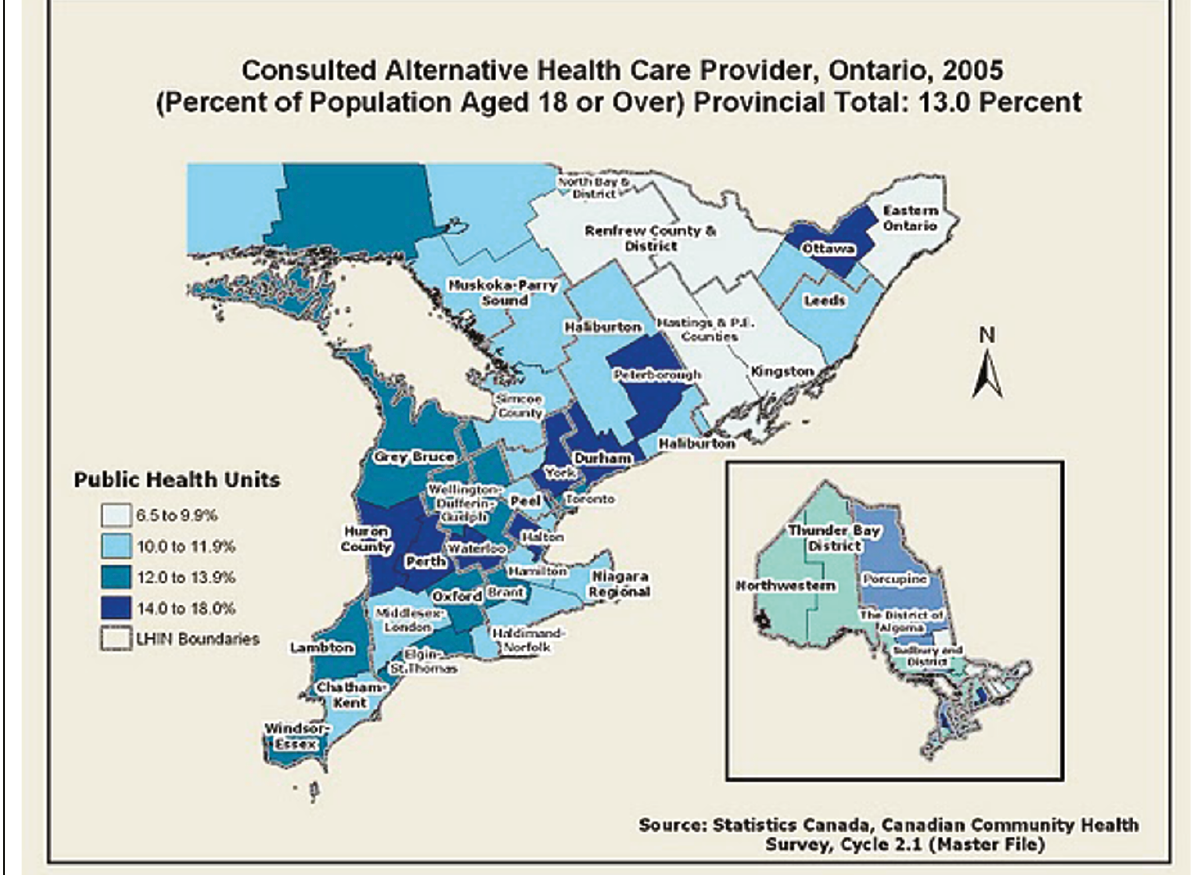
Figure 1 Map of alternative health care provider consultations in Ontario, 2005 .